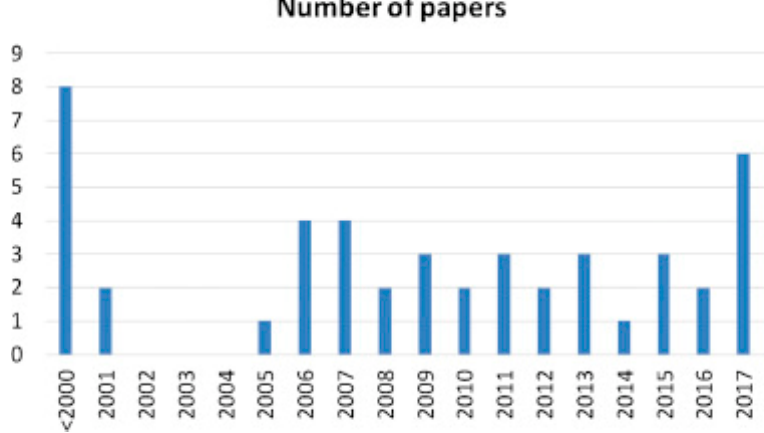
Figure 1. International papers per year [8].